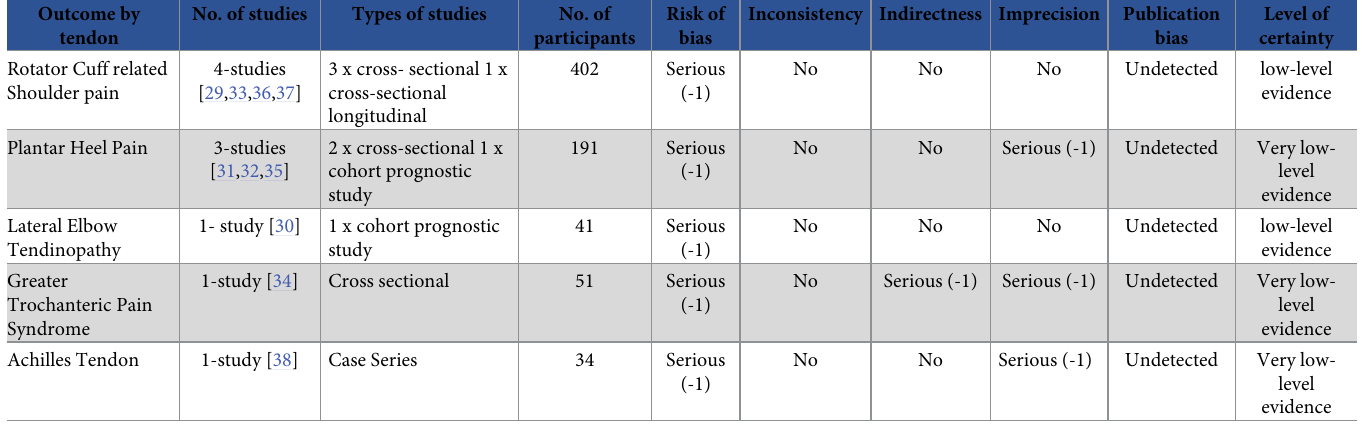
Table 4. Summary of findings and quality of evidence assessment